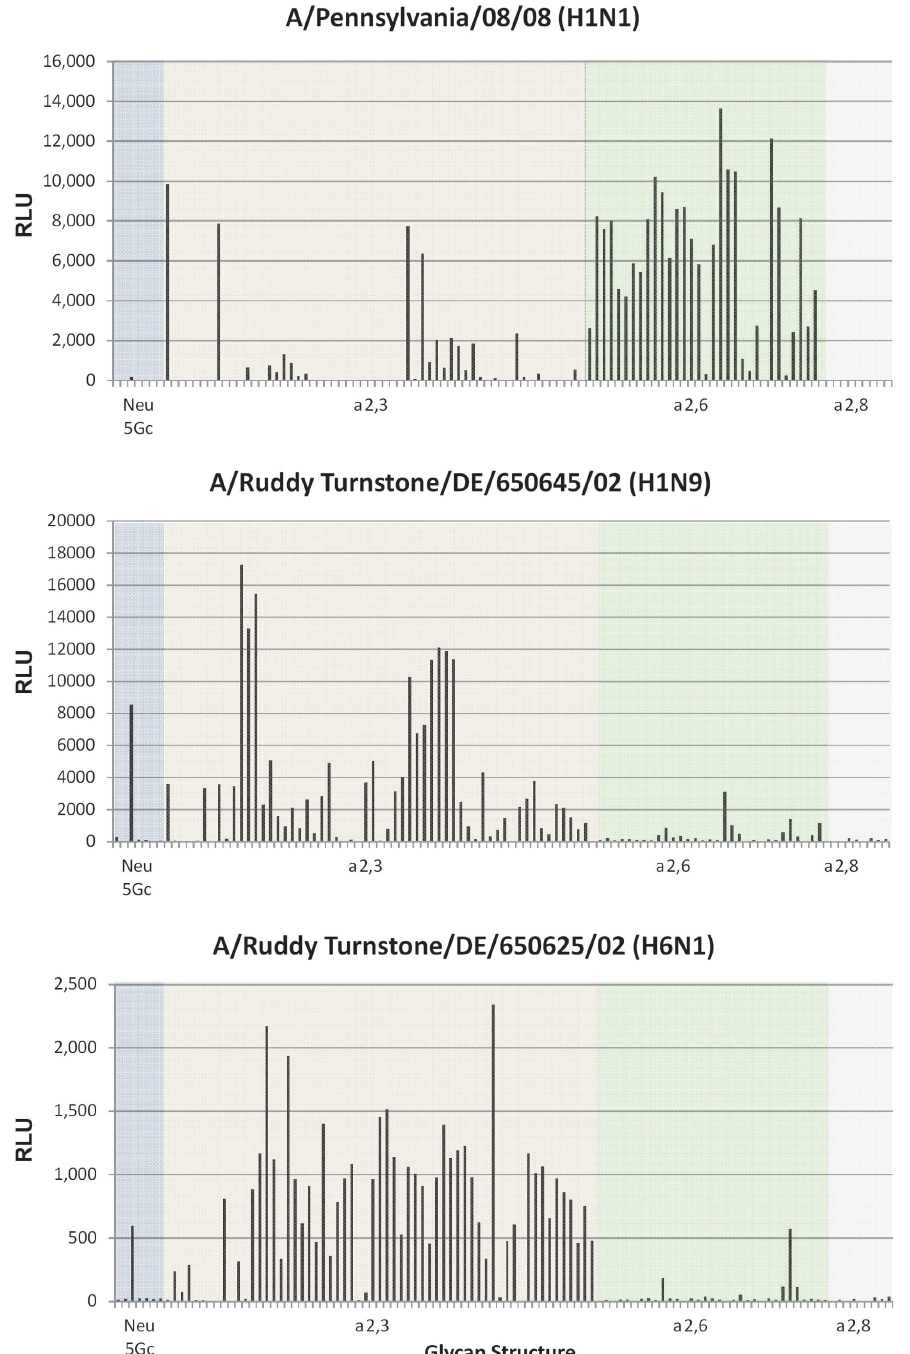
Figure 3. Glycan binding analysis of wild bird avian or human influenza viruses. Influenza viruses were propagated in Madin-Darby kidney cells, purified on a 25% sucrose cushion by ultracentrifugation, and labeled with Alexa488 before being applied to the microarray. The data was organized based on Neu5GC, a 2,3 SA, a 2,6 SA and a 2,8 SA glycan structures and represented by different color schemes. Glycan microarray binding analysis was performed by Core H of the Consortium for Functional Glycomics. A) A/Ruddy Turnstone/DE/1171/02 (H1N9), B) A/Ruddy Turnstone/DE/ 892/02 (H6N1), C) A/Pennsylvania/08/2008 (H1N1). doi:10.1371/journal.pone.0038067.g003 explore ocular infection in this study; however in light of the demonstrated infection and transmission with H7 influenza viruses, this should be an area of future study. H7 influenzas transmitted to naı¨ve contact ferrets [48]. We did not